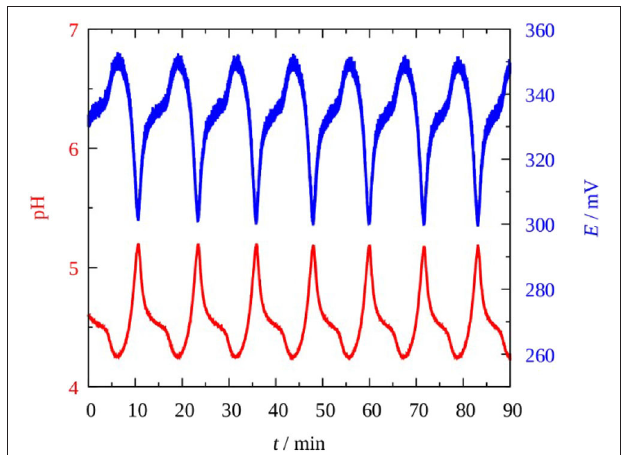
FIGURE 3 | Complex potential oscillations in the Pt vs. SCE electrode pair (blue) and the change in the pH (red) in the Cu 2 + -catalyzed sodium perborate–potassium thiocyanate batch system. [NaBO 3 ] = 0.010M; [KSCN] = 0.025M; [Cu 2 + ] = 4 × 10 − 4 M; T = 25 ◦ C.